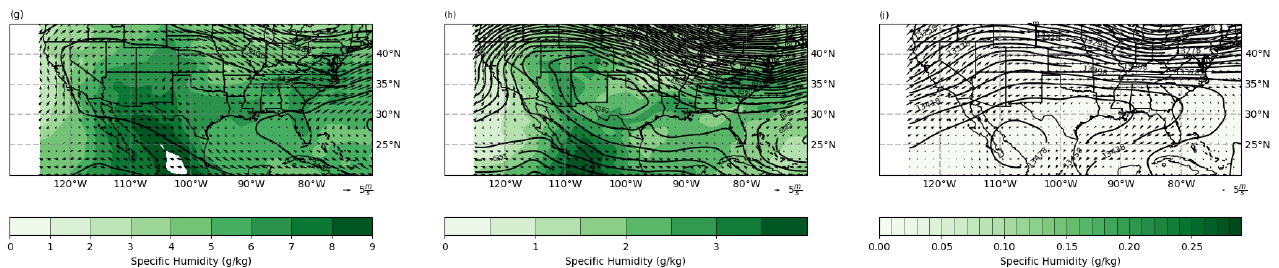
Figure 11. Composite of the atmospheric conditions at 700, 500, and 200 mb (left, central, and right panels) for the MCS trajectory 1 in the Band A ( a – c ), B ( d – f ), and C ( g – i ), respectively. Vectors are winds (m/s), contours are geopotential height (m), and green shading is specific humidity (g/Kg).